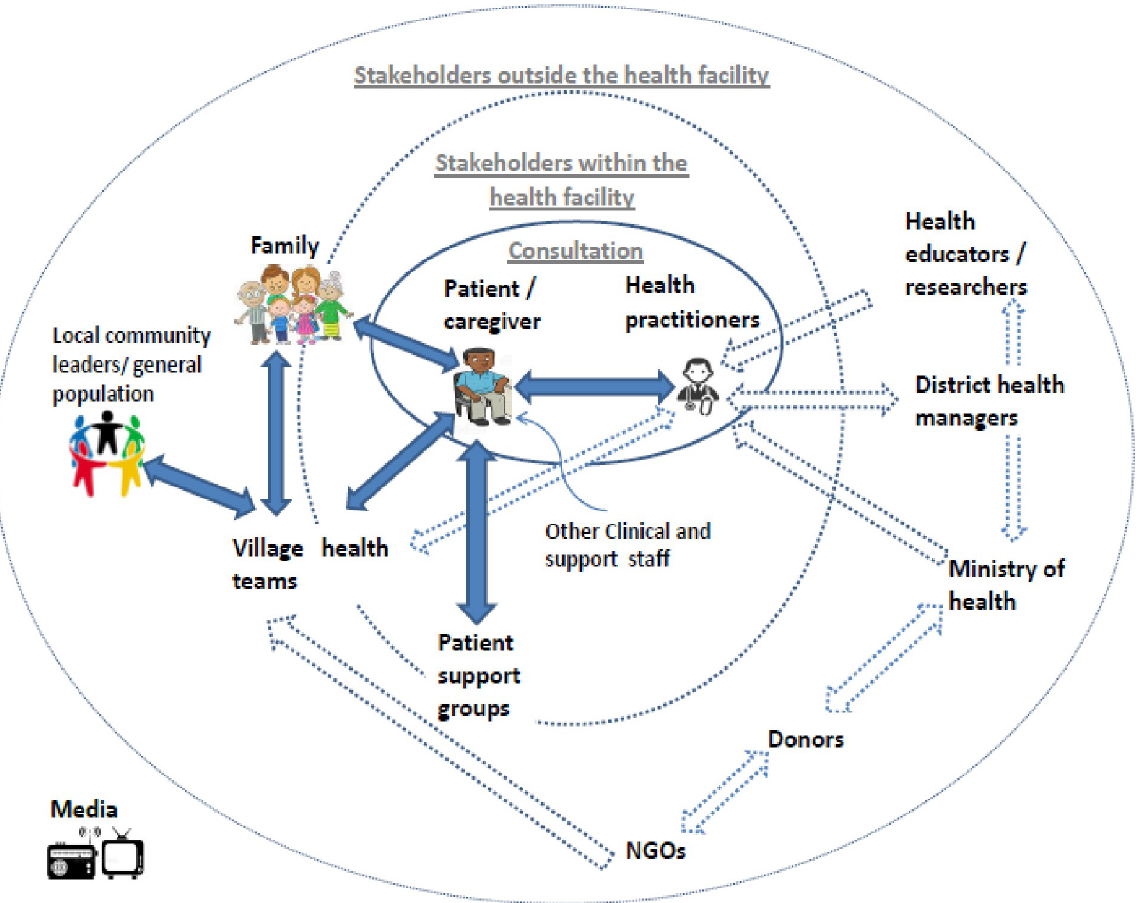
Fig 2. Mapping stakeholders involved in the provision of primary health care. A stakeholder map of actors involved in the provision of primary care based on document analysis, qualitative interviews and focus group discussions.